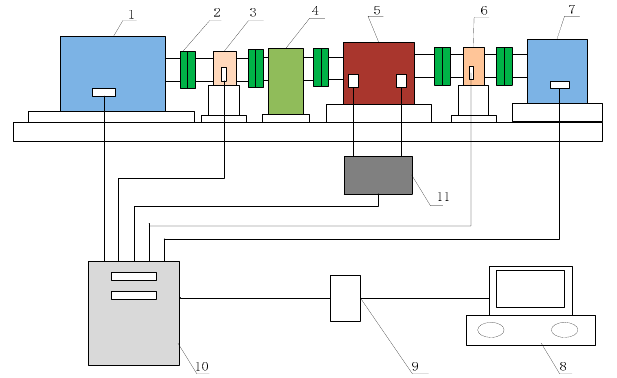
Figure 10. Schematic diagram of the HVC test rig. 1—drive motor; 2—coupling; 3,6—torque